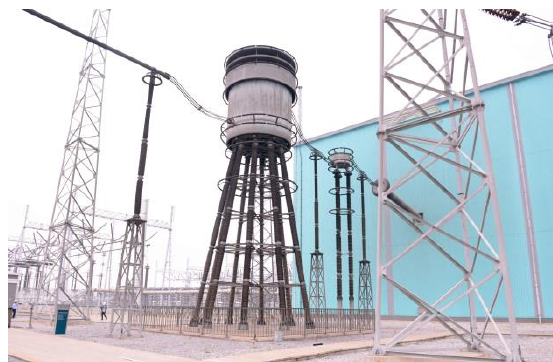
Figure 1. Pole bus smoothing reactor of the Jiaodong ±660 kV converter substation